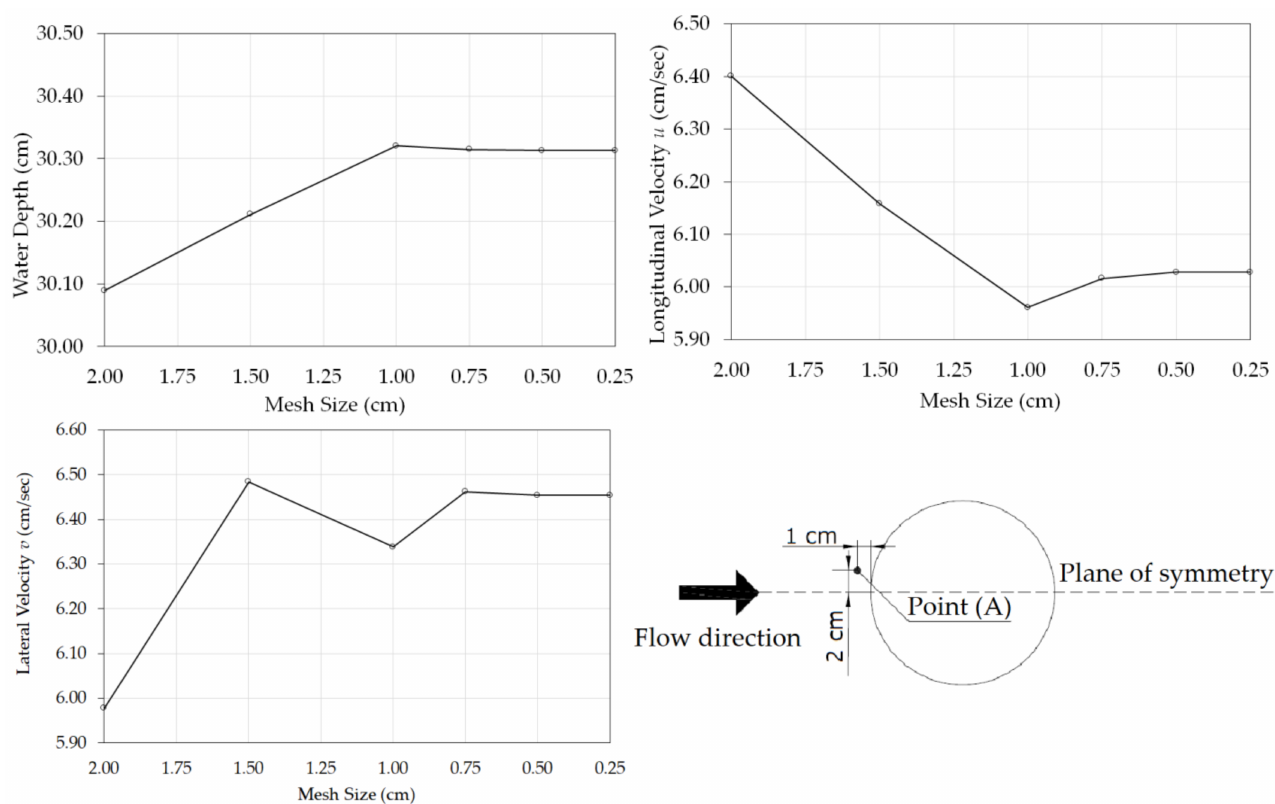
Figure 5. Variation of water depth and longitudinal and lateral velocities at point A for different mesh